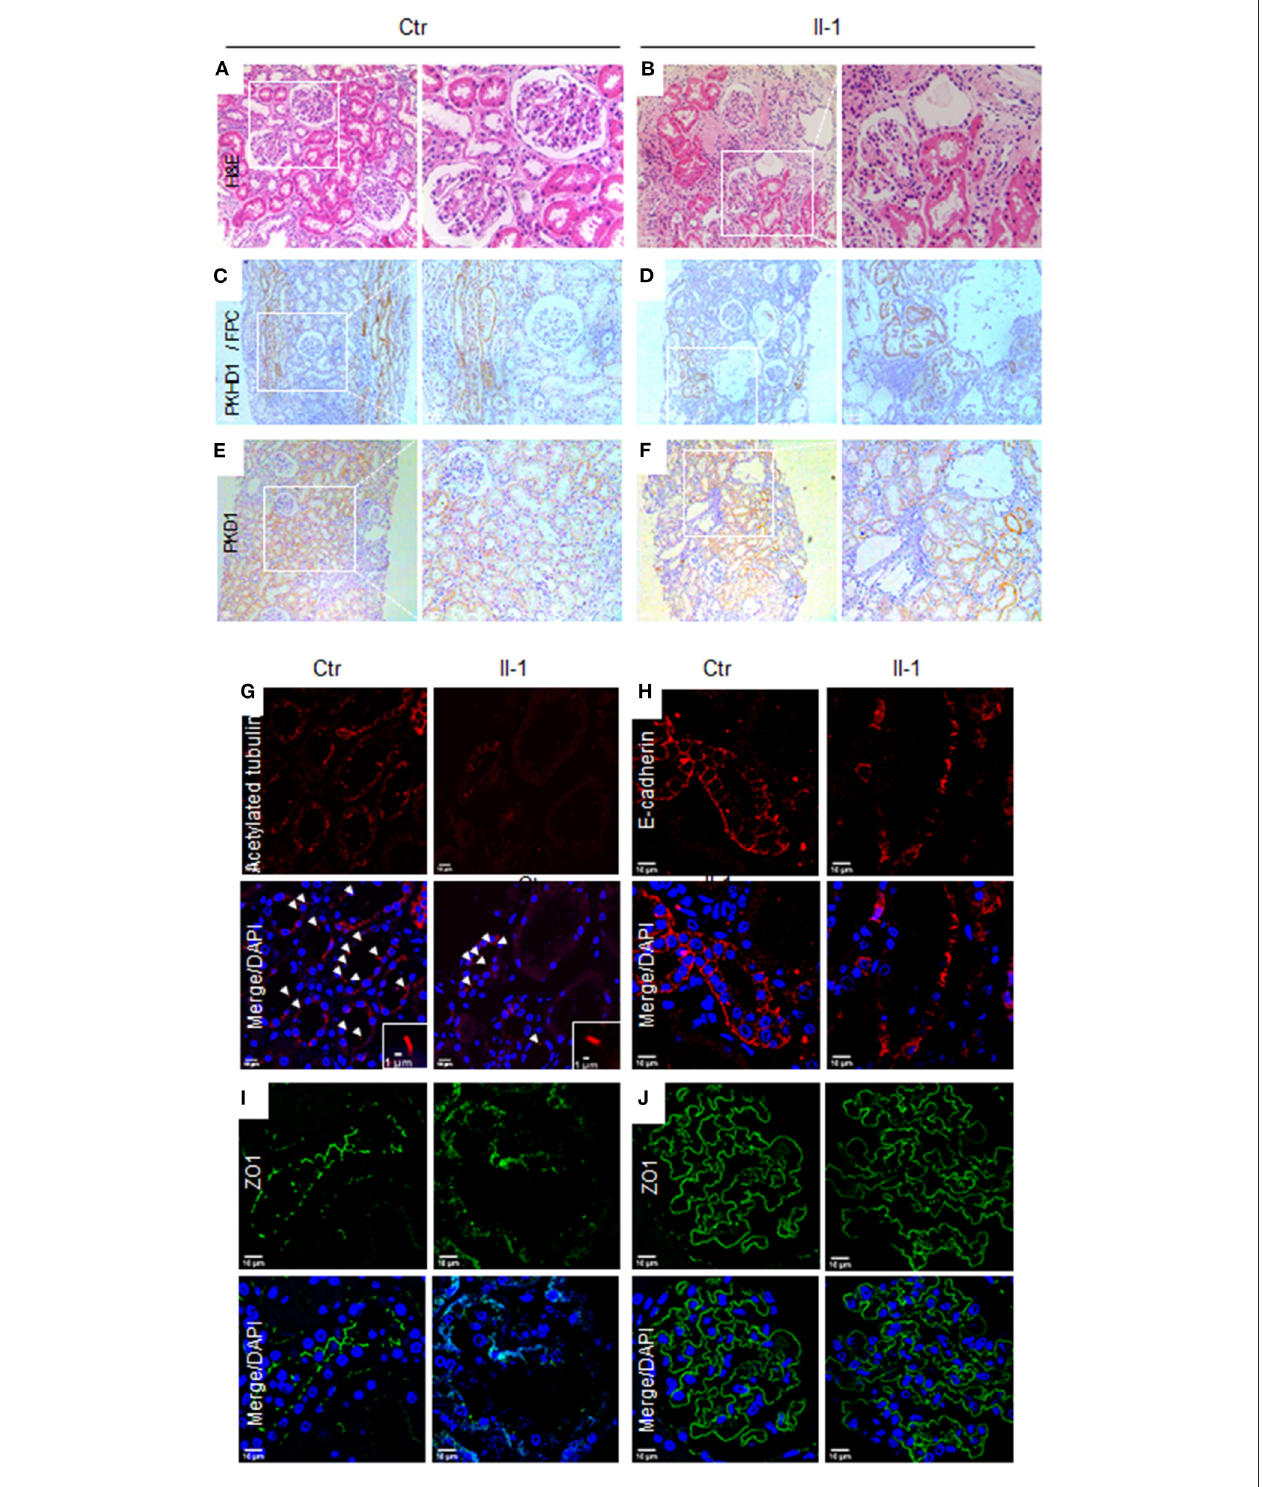
FIGURE 2 | Pathological features in biopsies for patients with the PKHD1 mutant. (A,B) H&E staining, illustrating patchy ectasia in the proximal tubules and flattening of the tubular epithelial cells in dilated tubules from proband (II-1) biopsy specimens, as compared to that of controls. (C,D) Immunohistochemical staining of PKHD1/FPC in the collecting ducts of control and patient biopsies. (E,F) Immunohistochemical images of PKD1. A detectable difference was not revealed between